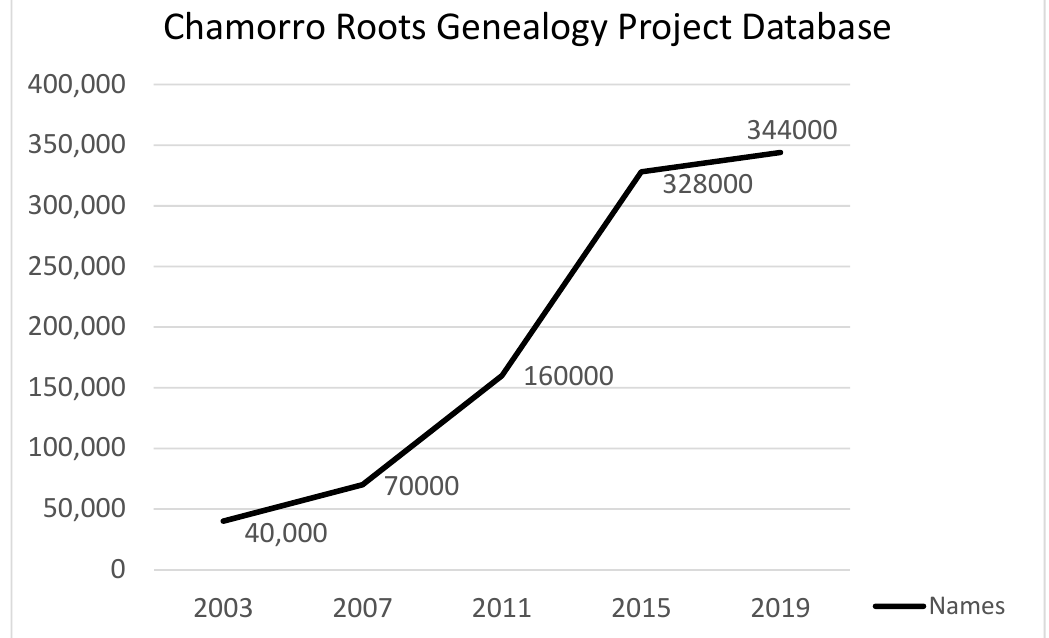
Figure 1. Timeline of Database Growth.